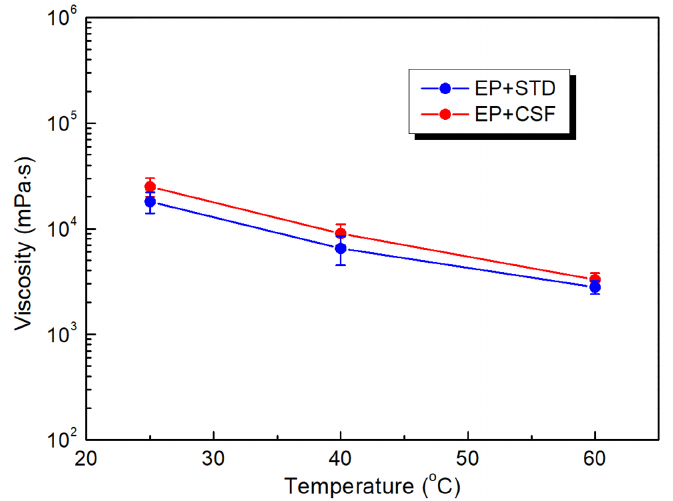
Figure 2. Temperature dependence of the initial viscosity for the epoxy system filled with reference (STD) and core-shell (CSF) particles.